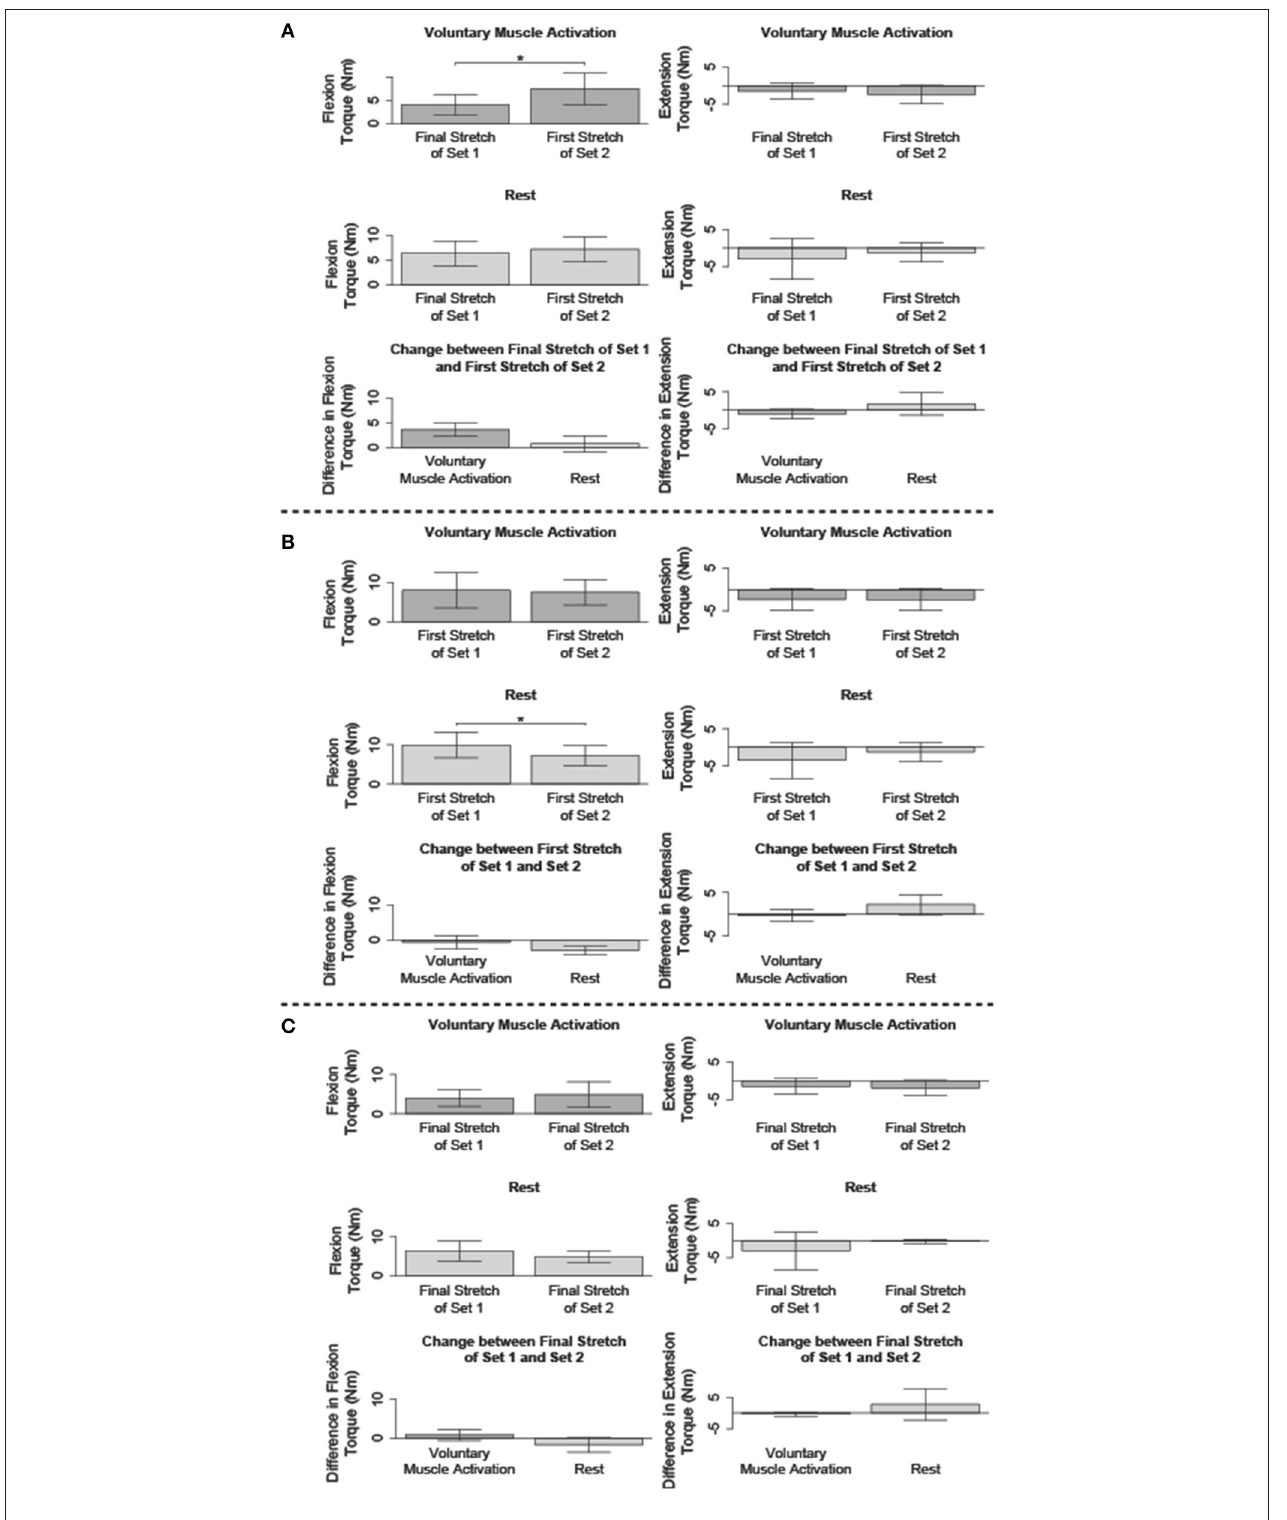
FIGURE 5 | Comparison of the flexion and/or extension torque during specific stretches. Mean (bar height) and lower and upper 95th percentile confidence intervals (error bars) are identified. A line with a star above indicates a significant difference. Comparison between the: (A) final fast stretch of set 1 and initial fast stretch of set 2, (B) initial fast stretch of set 1 and initial fast stretch of set 2, and (C) final fast stretch of set 1 and final fast stretch of set 2.